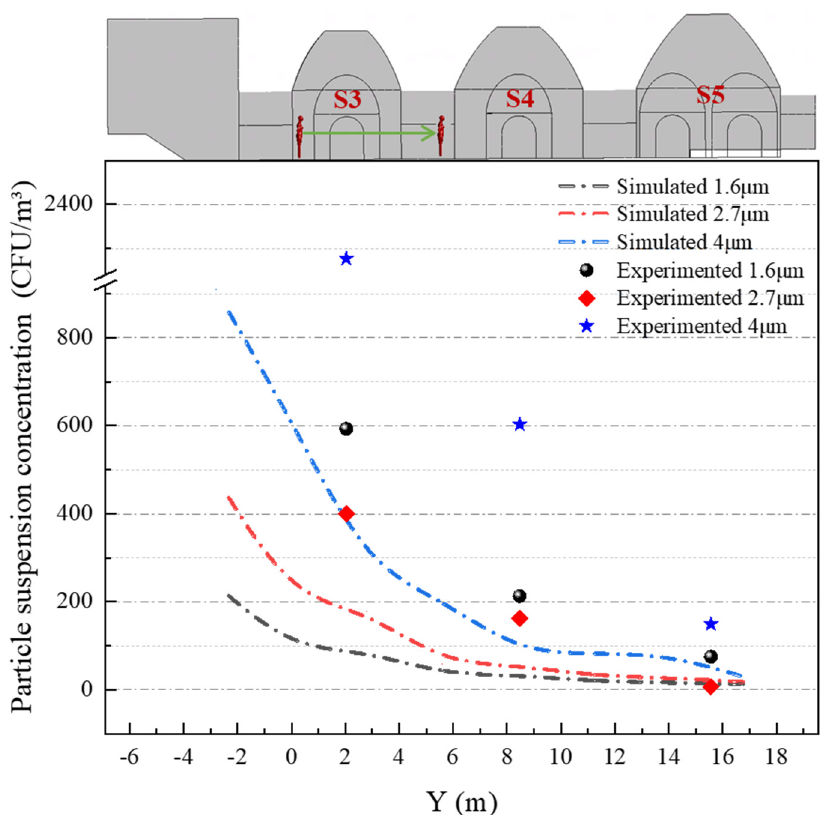
Figure 4. Verification of concentration of BPs of three diameters.